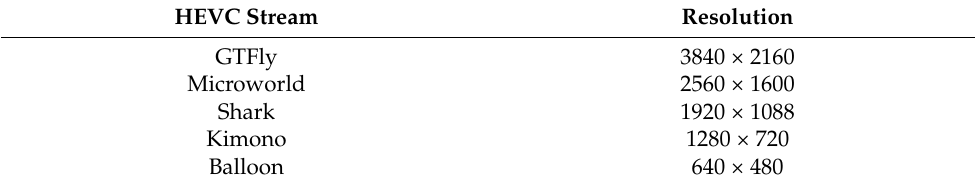
Table 1. Resolution of the tested video streams.